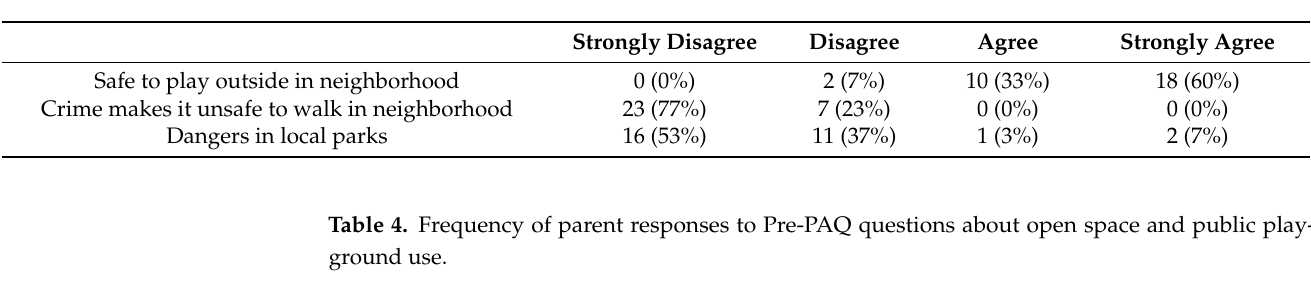
Table 3. Frequency of parent responses to Pre-PAQ questions about neighborhood and park safety.